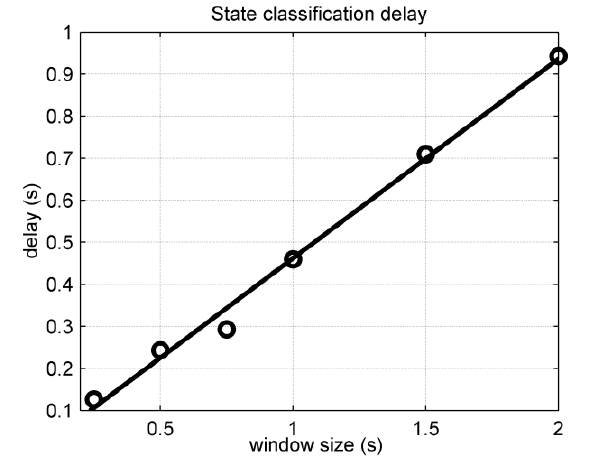
Figure 16. Measured delays linked with an interpolation